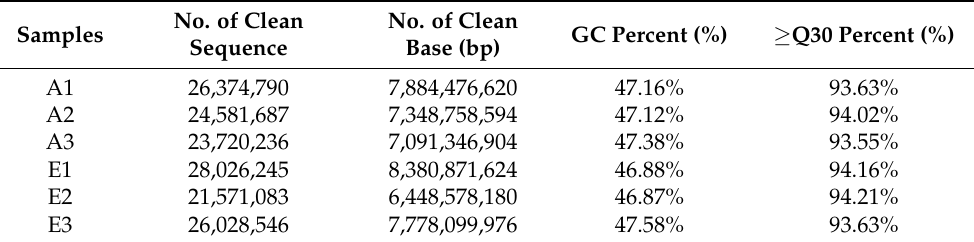
Table 1. Summary of transcriptome sequencing-related information of BPH after 48 h feeding on GC film-forming emulsion-treated rice.